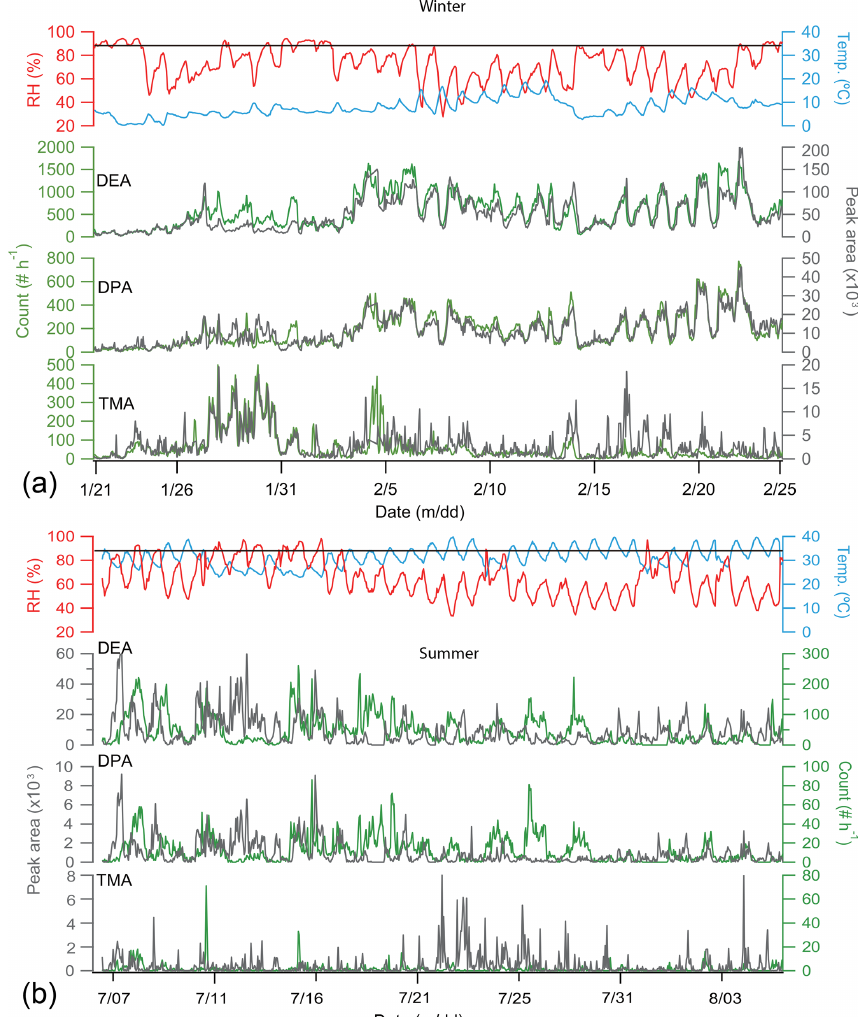
Figure 2. Temporal trends of relative humidity (RH), temperature (Temp.), hourly peak area (dark gray), and particle count (green) of particles containing DEA ( m/z 74), DPA ( m/z 86), and TMA ( m/z 59) in winter (a) and summer (b) . The black lines in the two panels indicate RH of